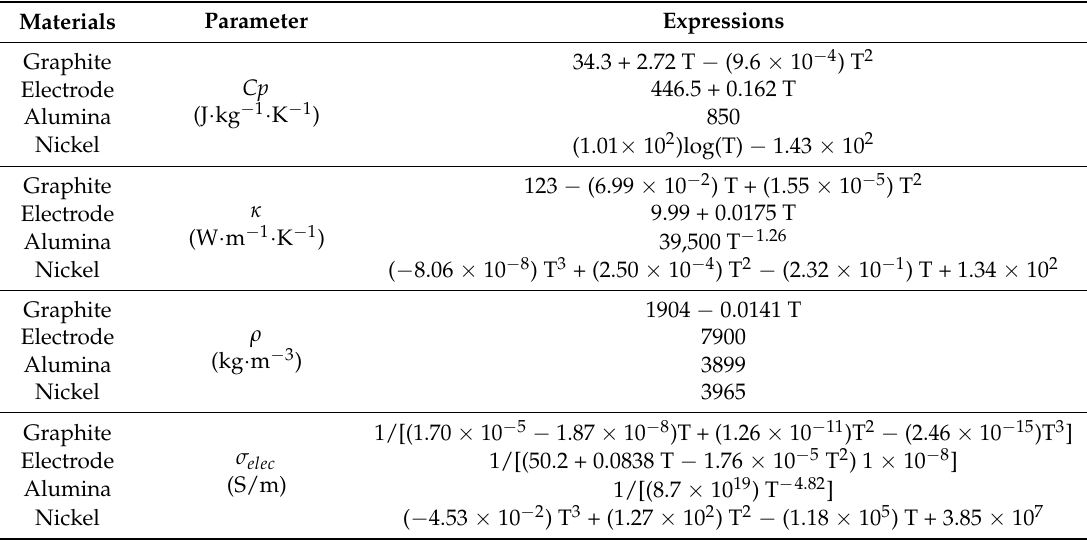
Table A1. Electrothermal materials